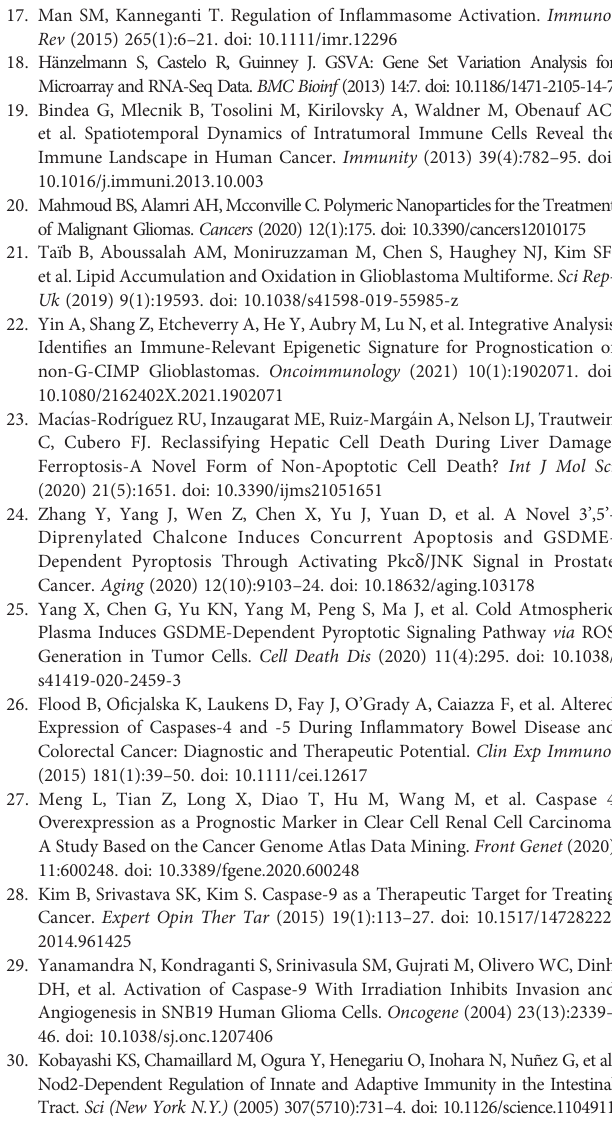
Supplementary Table 2 | The correlation between in fi ltrating immune cell types in GBM and three